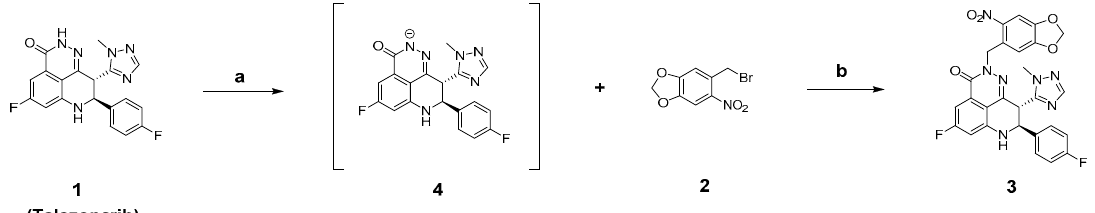
Figure 2. Predicted ligand binding models relative to the catalytic domain of poly (ADP-ribose) polymerase 1 (catPARP-1). ( A ) The co-crystallized binding modes of Talazoparib and the catPARP-1 protein were taken from PDB ID 4PJT. ( B ) Predicted co-crystallized binding poses of compound 3 in a complex with catPARP-1. ( C ) Superimposition of the binding models of Tazaloparib (blue) and compound 3 (red) with catPARP-1 protein (green).